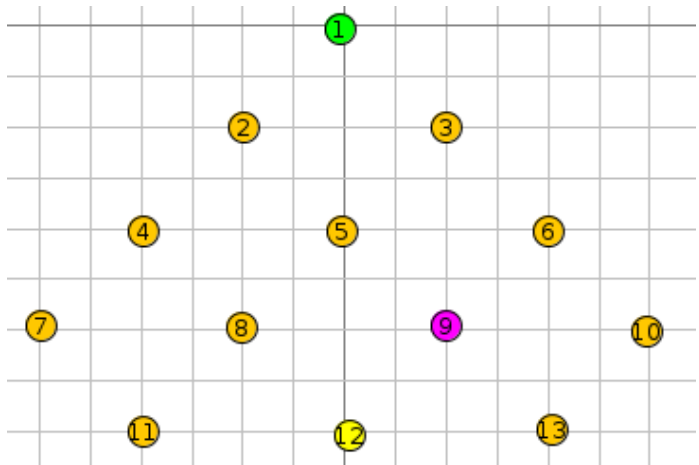
Figure 8. Network topology of DAO insider attack detection. Node 1 is the central IDS. Node 9 is an IDS detector. Node 12 is the DAO insider attacker. The rest of the nodes are dummy nodes.